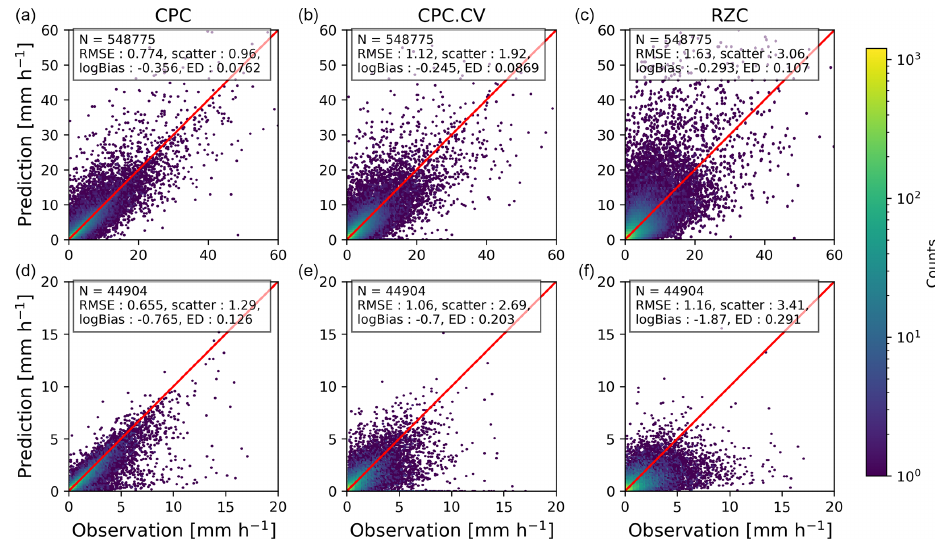
Figure 4. Scatter plots and performance scores of the reference products CPC, CPC.CV and RZC for all available observations (a, b, c) and for observations with T < 2 ◦ C (d, e, f) . The 1 : 1 line is shown in red. The color bar gives the counts in logarithmic